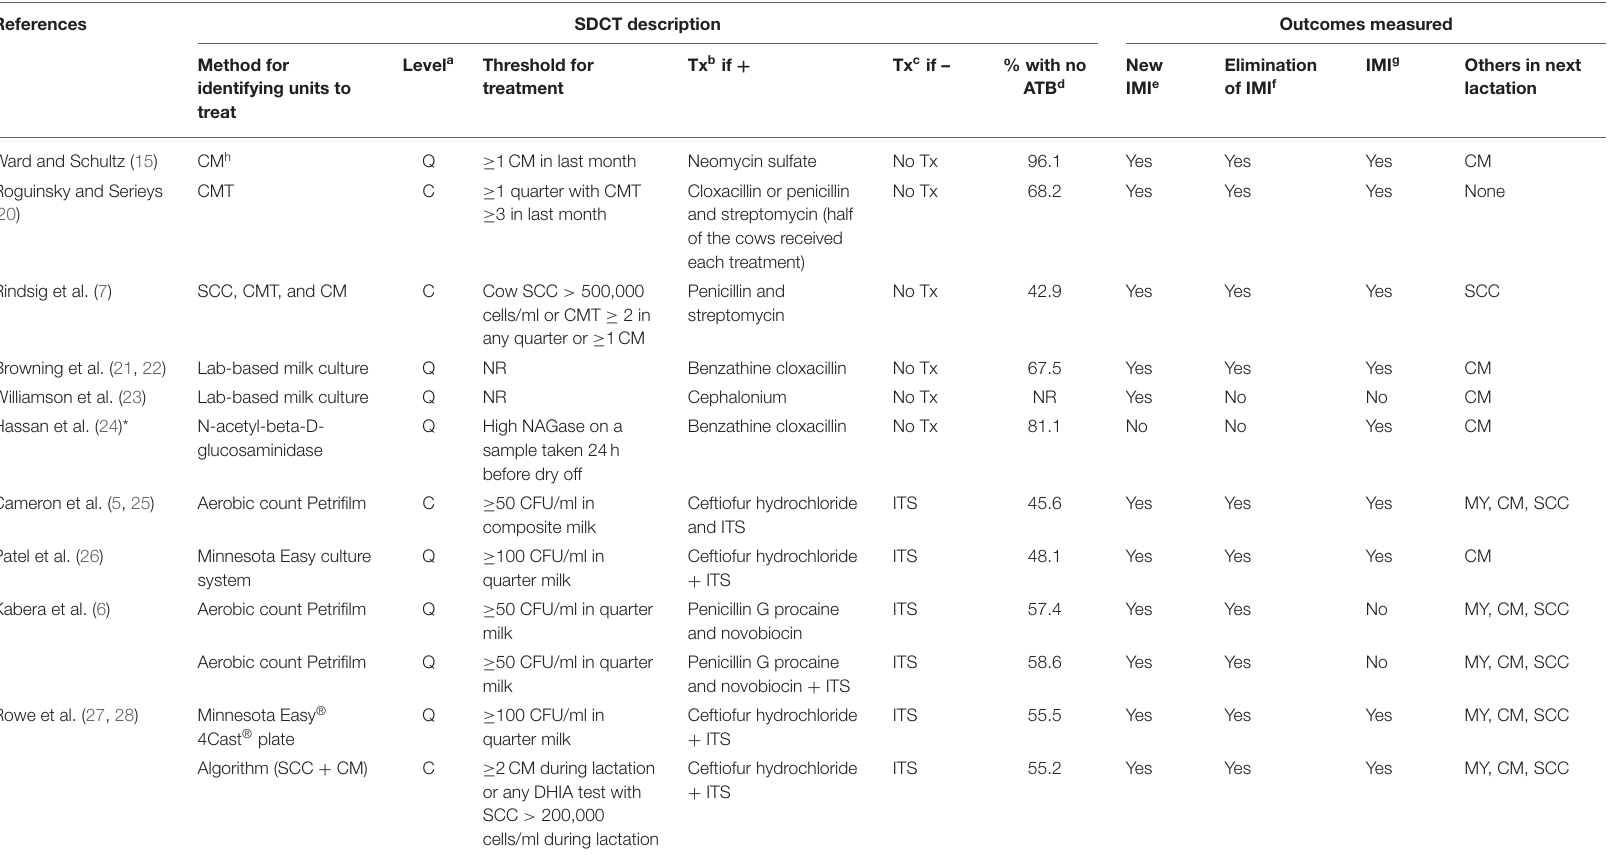
TABLE 2 | Treatment regimens and outcomes studied in 13 articles representing 12 trials included in a systematic review comparing selective dry cow therapy (SDCT) and blanket dry cow therapy